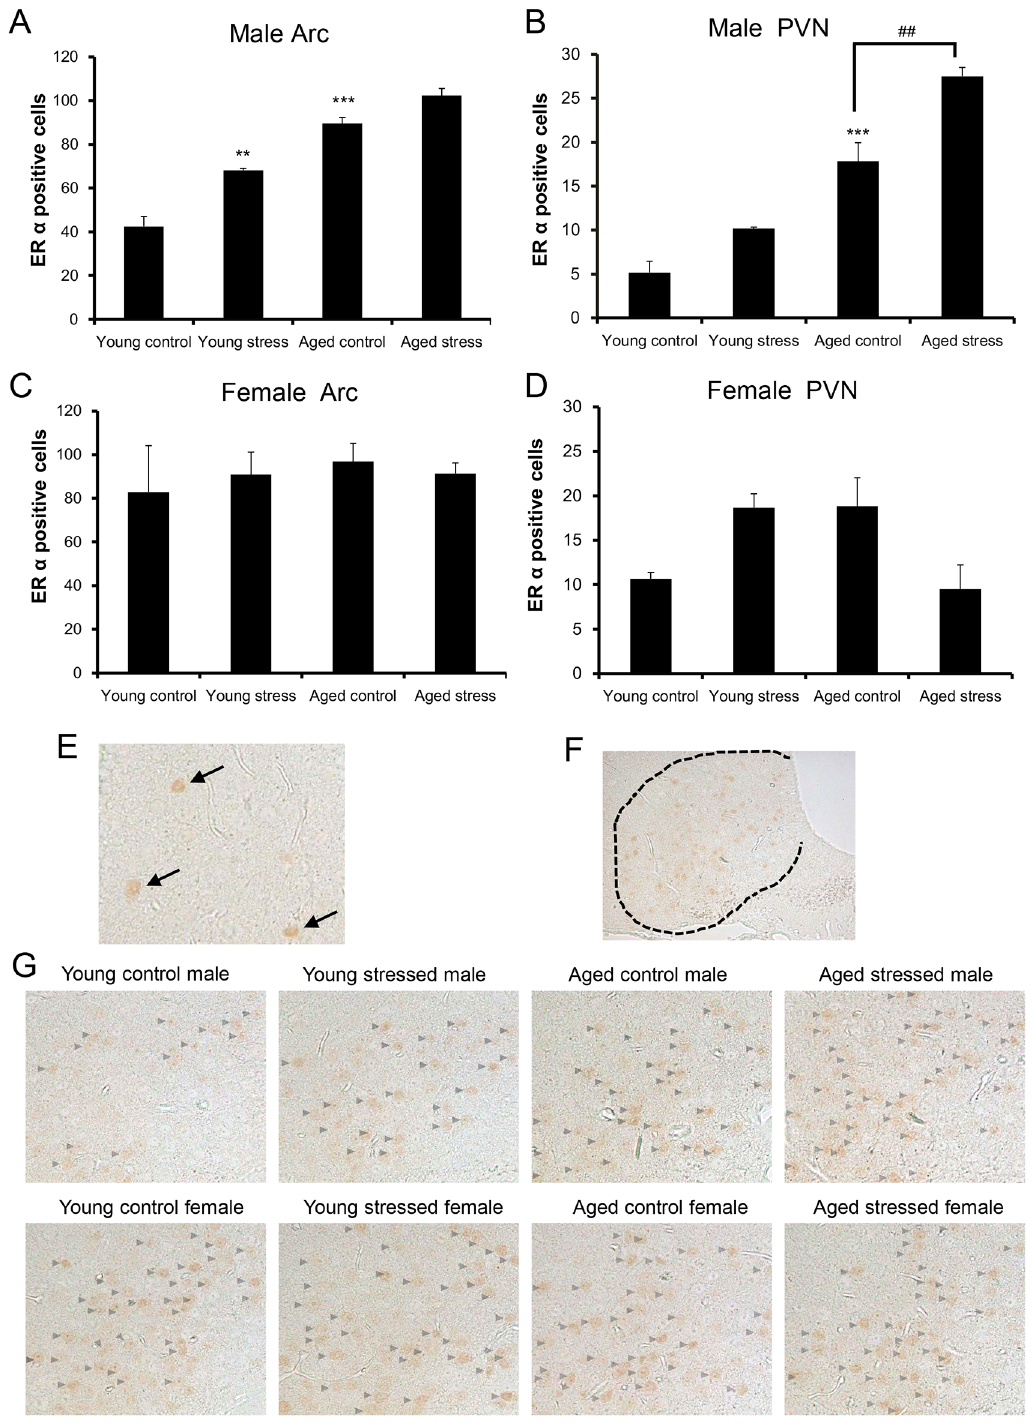
Fig 6. Changes in the number of ER α -positive cells in aged male or female mice exposed to novelty stress. (A) Male Arc, (B) Male PVN, (C) Female Arc, (D) Female PVN. The hypothalami were harvestedfrom 18 h-fasted mice at 6 h after stress exposure. Data are presented as the mean ± SEM (young control, young stress, agedcontrol groups; n = 3, agedstress group; n = 4). ** , *** , p < 0.01, 0.001 vs. young control group. ##, p < 0.01 vs. aged control group. (E) Typical immunoreactivity for ER α -positive cells, (F) MeasuredArc area, (G) ER α expressionin the Arc.